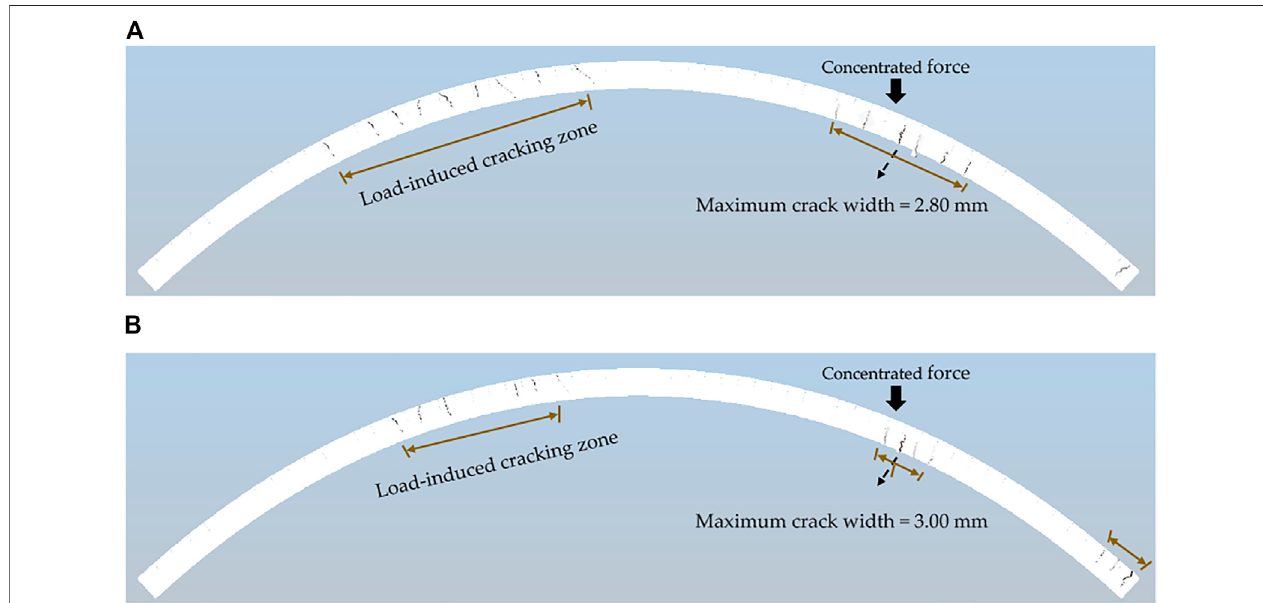
FIGURE 11 | Distribution of transverse cracks caused by loading: (A) arch 0# and (B) arch 1#.